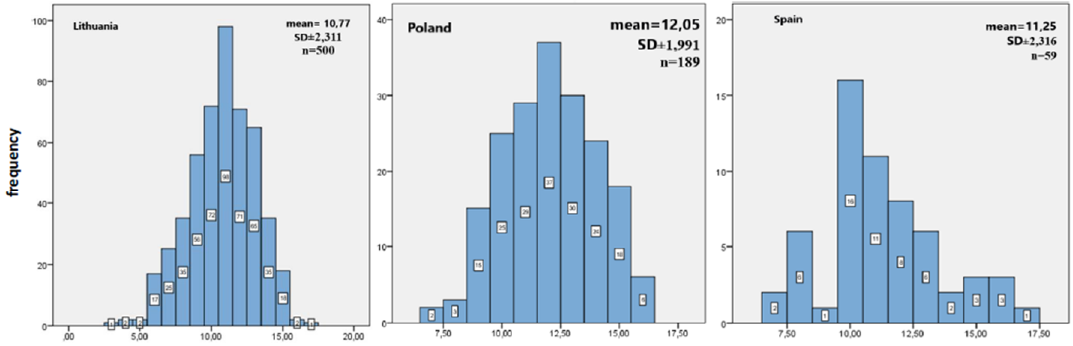
Figure 1. The distribution of the score points within the level of knowledge about CPR—Lithuania, Poland and Spain.